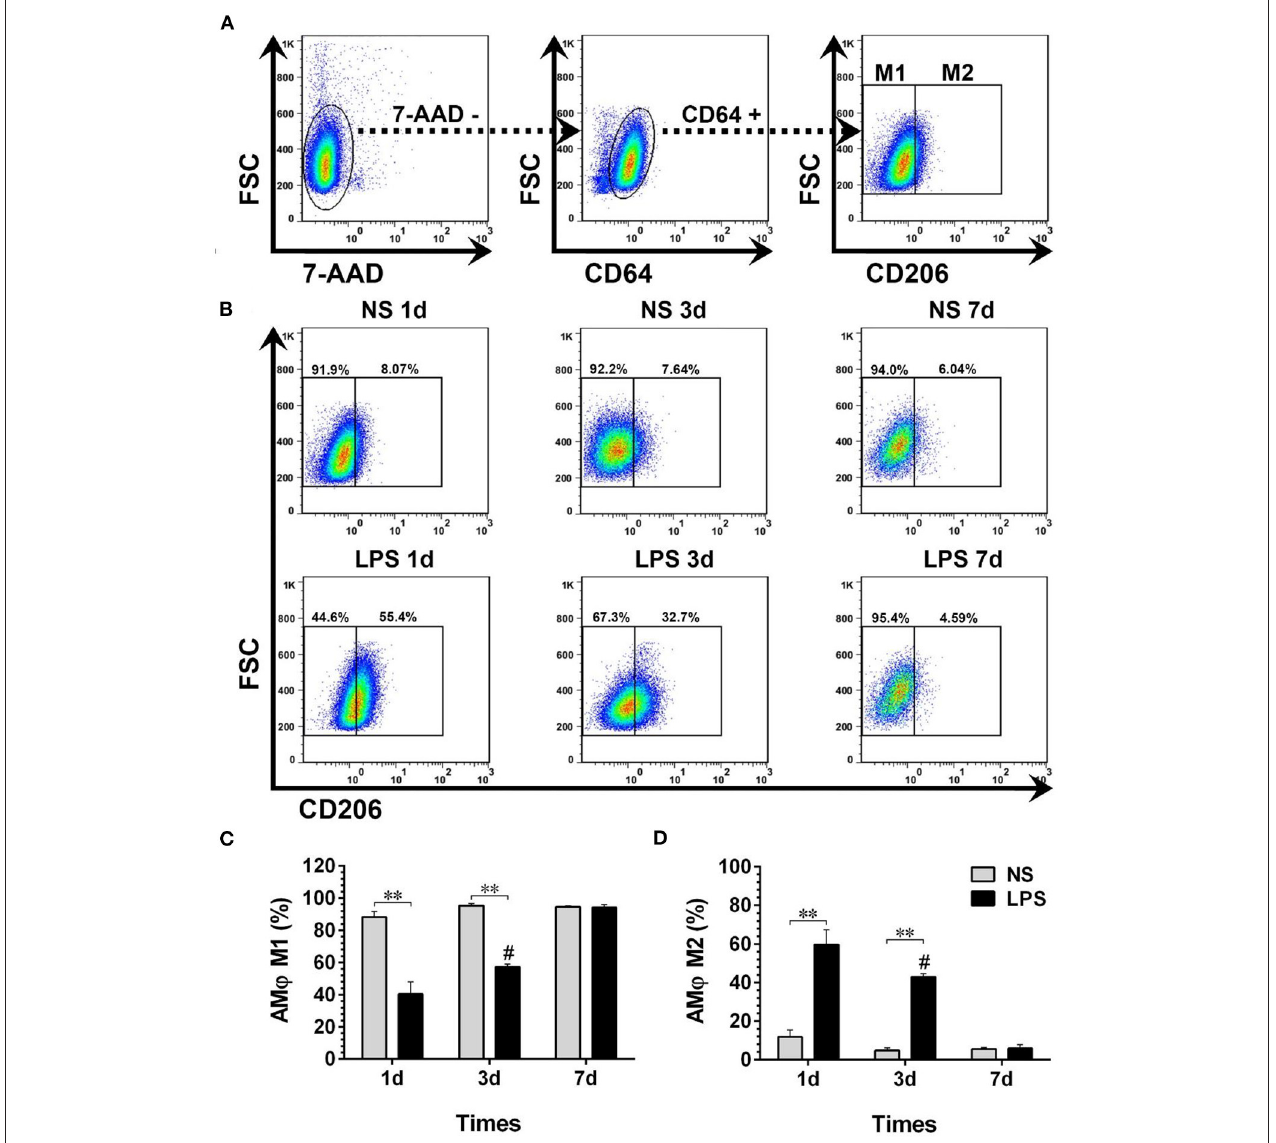
FIGURE 5 | Temporal dynamic changes of AM φ subpopulations after LPS stimulation. (A, B) M1- and M2-like AM φ were identified by flow cytometry. Numbers outside boxed areas indicate the percentage of cells. The gating strategies for pulmonary AM φ subpopulations is shown in (A) . The dynamic characteristics of lung M1- and M2-like AM φ in NS and LPS groups are shown in (B) . (C, D) Kinetics of increase in M1- and M2-like AM φ numbers in BALF-isolated cells. FSC, forward-scattered light; SSC, side-scattered light. # p < 0.05, compared with the LPS group on day 1; ** p < 0.01. ( n = 5 in each